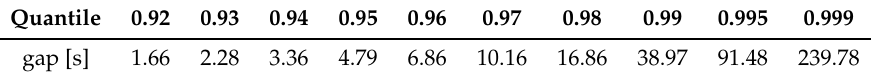
Table 1. DumbBell quantiles (mean of BER 9 × 10 − 5 configurations).